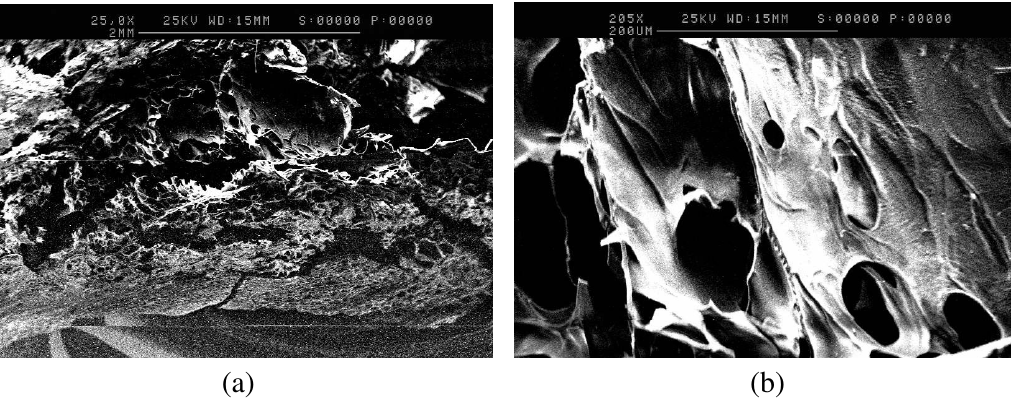
Figure 5. ( a ) SEM image of the tablet matrix of the 1:30 gelatin:soluble salt molar ratio formulation. Vertical Sample. Low Magnification, ×25; ( b ) SEM image of the tablet matrix of the 1:30 gelatin:soluble salt molar ratio formulation. Vertical Sample. High Magnification,